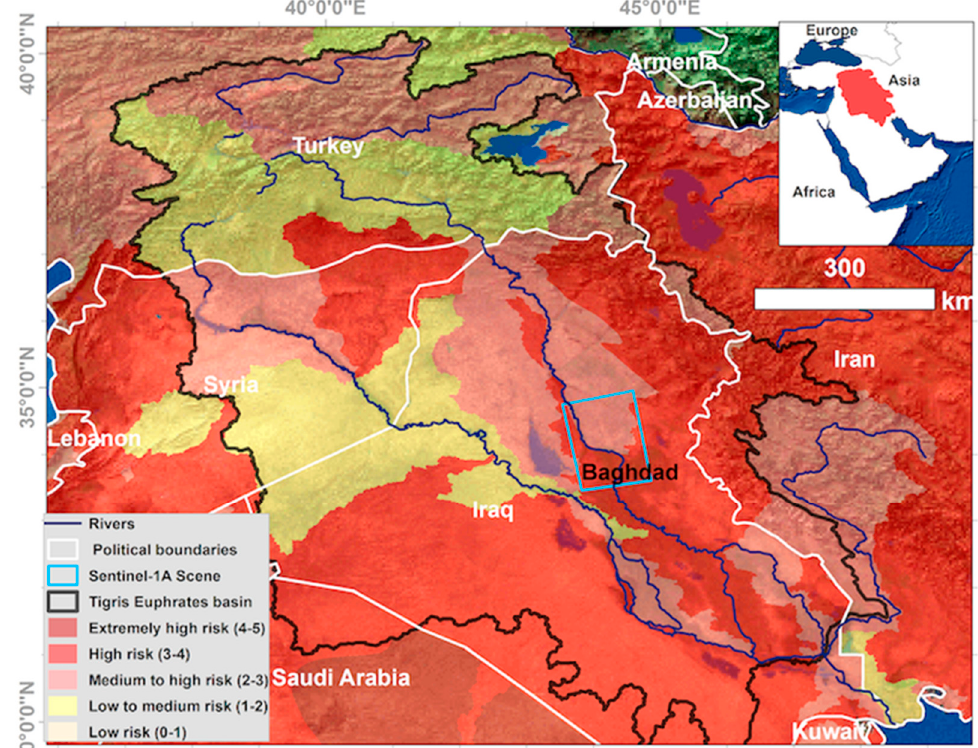
Figure 1. Water risk in the Tigris–Euphrates basin (TEB) based on different indicators (baseline water stress, drought severity, interannual variability, and groundwater stress) obtained by linear aggregation in the Aqueduct tool [15]. The white lines mark the political boundaries, the black polygon indicates the basin boundaries, and the dark blue lines show the Tigris and Euphrates rivers. The blue rectangle represents the Sentinel-1 (path 72 and frame 106) of an ascending orbit.